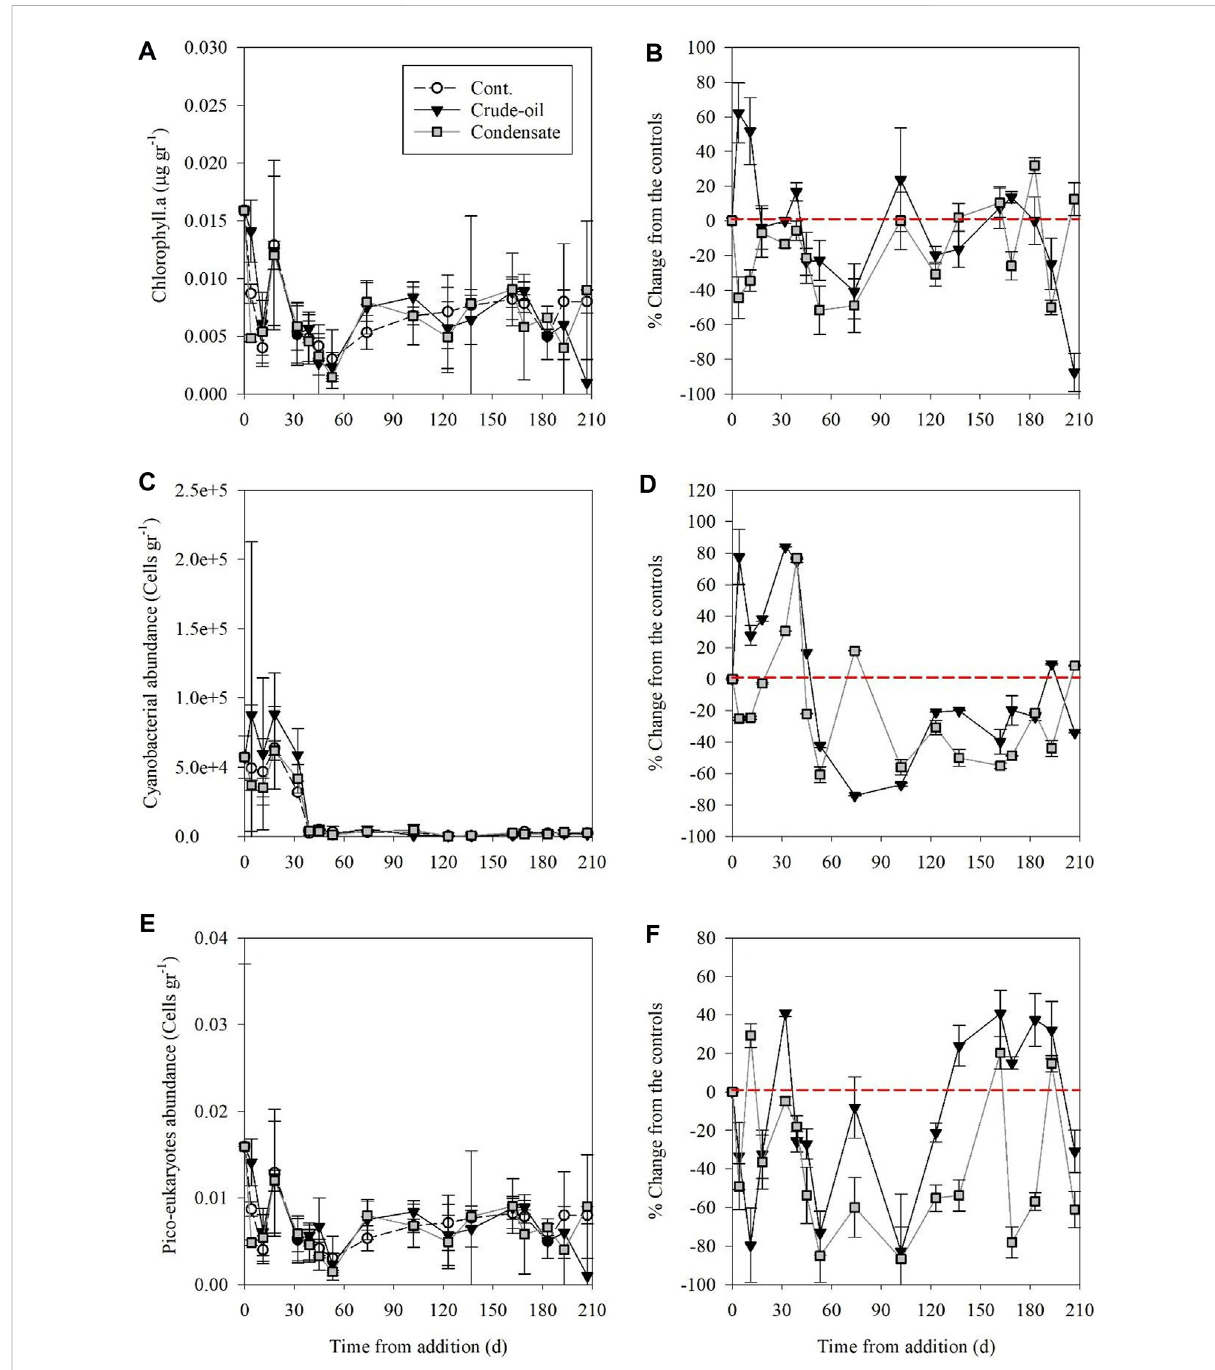
FIGURE 4 The temporal variability of surface sediment chlorophyll. a (A, B) , cyanobacteria (C, D) and picoeukaryotic algae (E, F) following crude oil (black triangle) and gas condensate (grey square) additions and in the unamended control benthocosms (white dots). The values shown are the average of three independent “ biological ” replicates and their standard deviations. The red dashed line indicates no change between the treatments and the unamended controls at each time